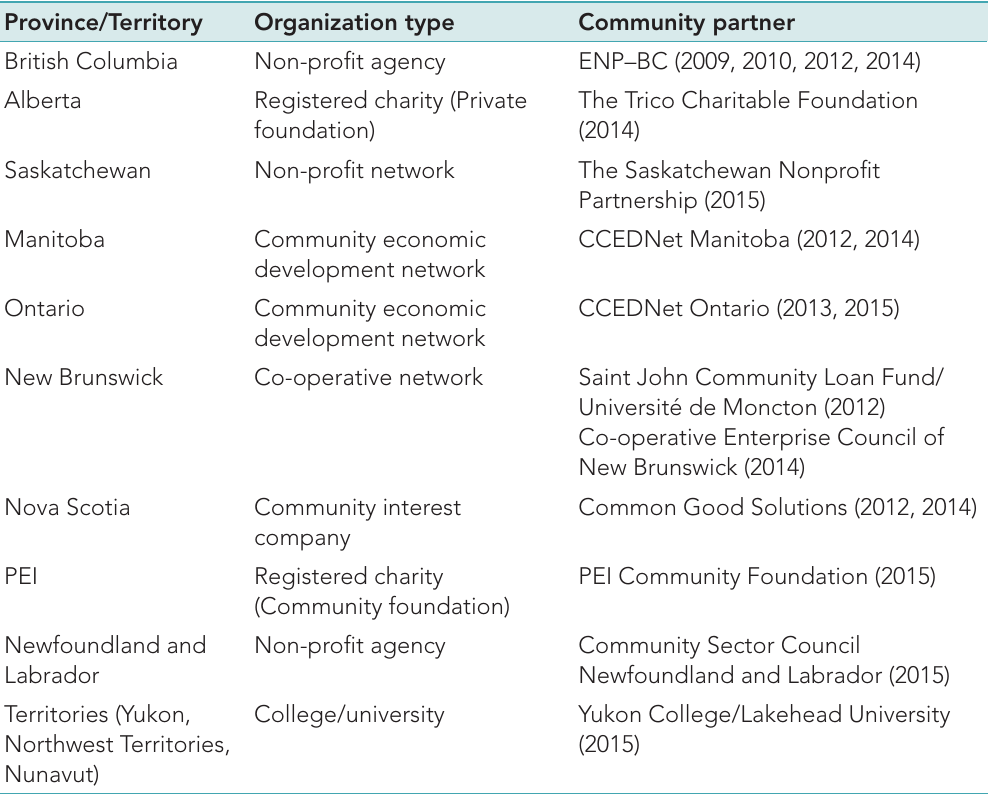
Table 3: Community partners